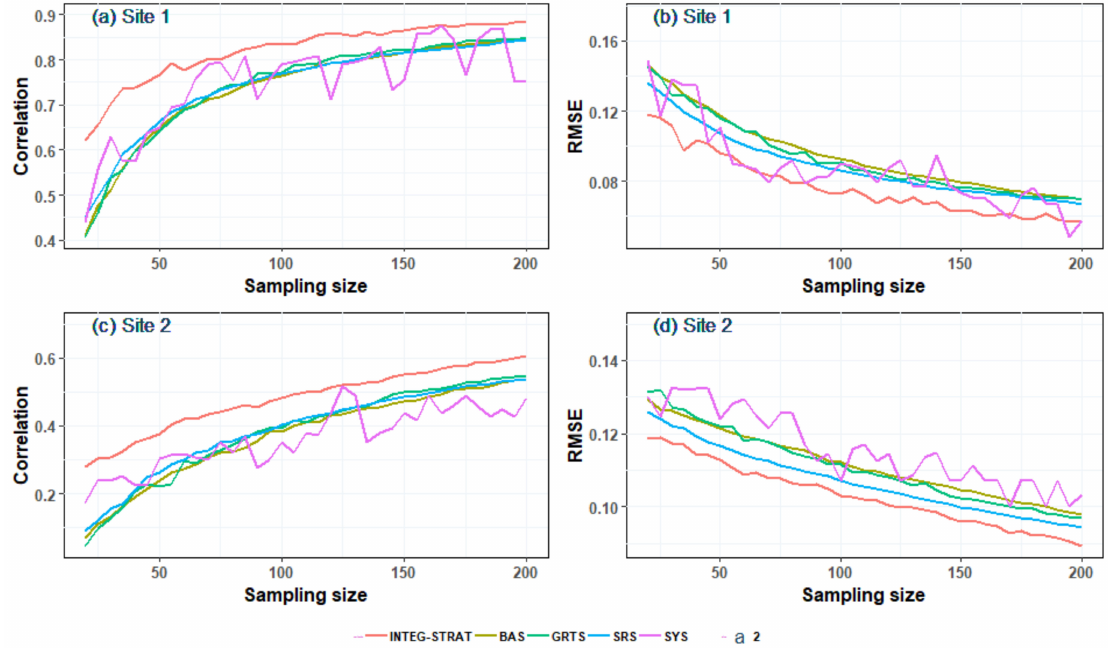
Figure 6. Comparing of the correlation and RMSE between the NDVI image and the interpolated surface: ( a , c ) correlation and ( b , d ) RMSE at sites 1 and 2,